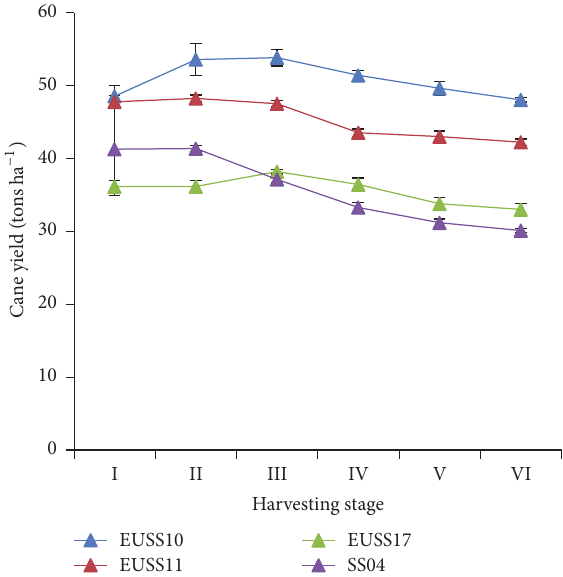
Figure 3: Effect of harvesting stage on cane yield of four sweet sorghum genotypes evaluated in western part of